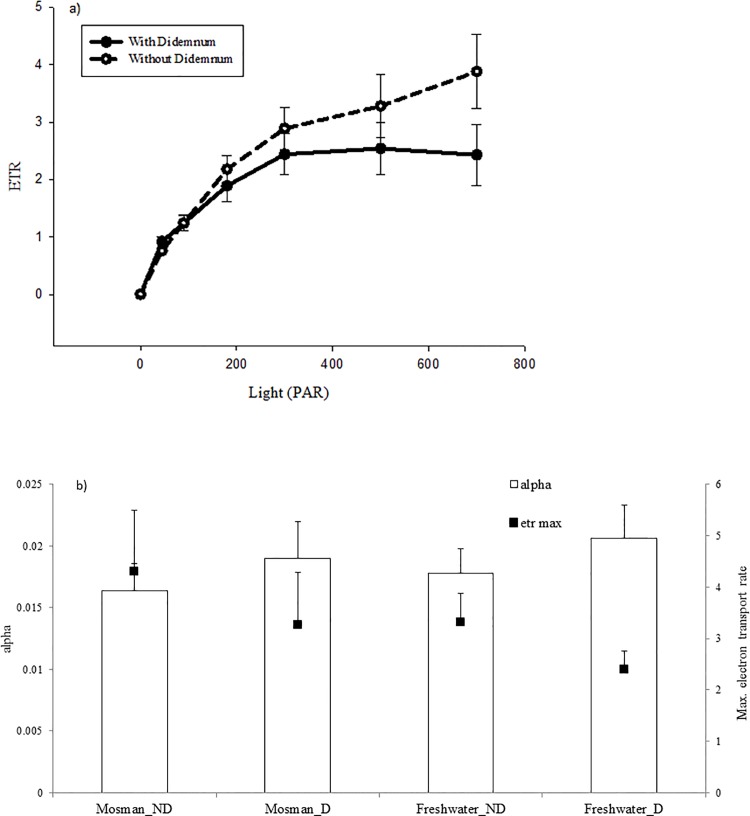
a) Relative light curve of H. ovalis tissues with and without D. perlucidum. b) α and ETRmax of H. ovalis tissue. D = plant tissue which had been covered with D. perlucidum colony. ND = plant tissue not impacted by D. perlucidum